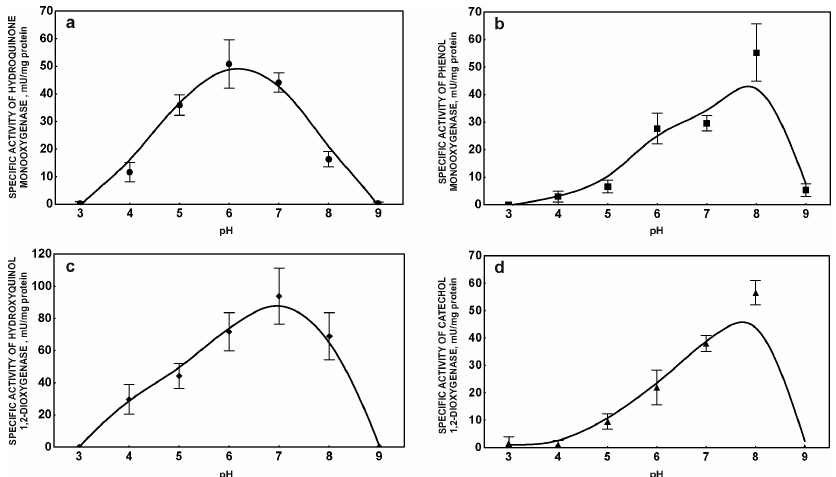
Figure 2. Influence of pH on the activity of hydroquinone monooxygenase ( a ); phenol monooxygenase ( b ); hydroxyquinol 1,2-dioxygenase ( c ); and catechol 1,2-dioxygenase ( d ). The data points represent the average of three independent experiments.